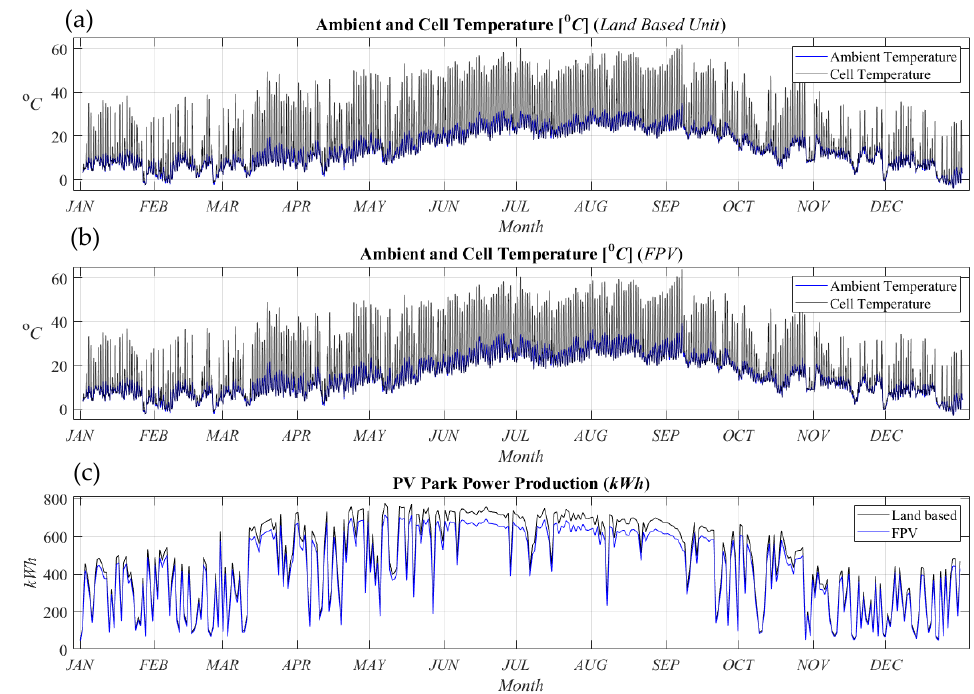
Figure 11. Simulated time series of temperature and power performance for land-based and FPV 100 kWp configuration considered at the geographical location of Pagasitikos Gulf region. Ambient and cell temperature of ( a ) land-based unit and ( b ) FPV, and ( c ) comparative daily power production in a TMY.